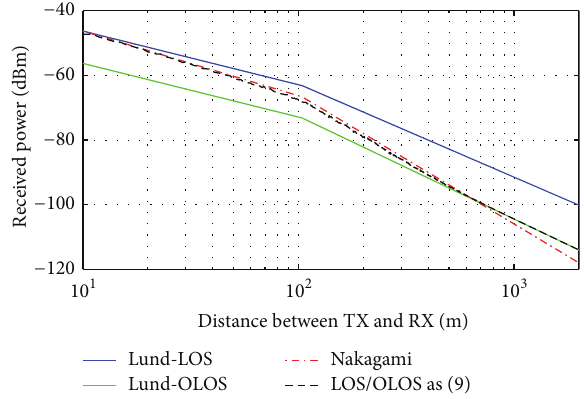
Figure 9: The averaged received power for the LOS/OLOS model and Cheng’s Nakagami model, respectively.